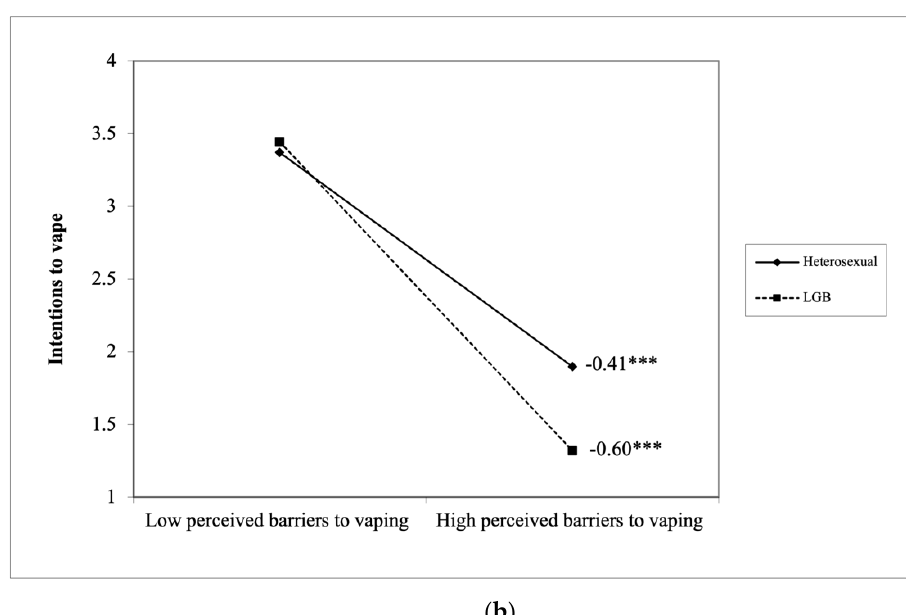
Figure 2. ( a ) LGB moderates how the perceived health threat of vaping predicts intentions to vape. ( b ) LGB moderates how perceived barriers to vaping predicts intentions to vape. *** p < 0.001.